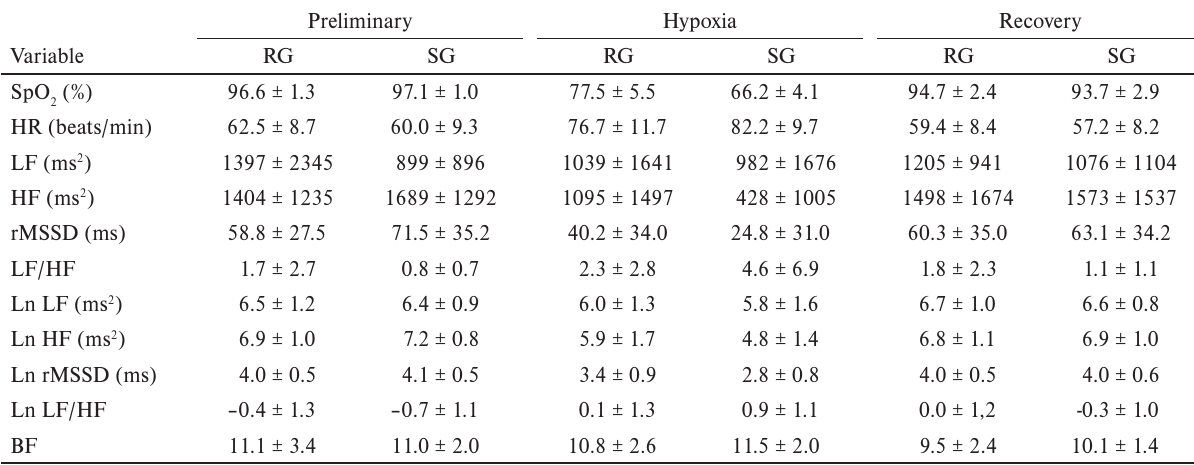
Table 1 Means and SDs of SpO